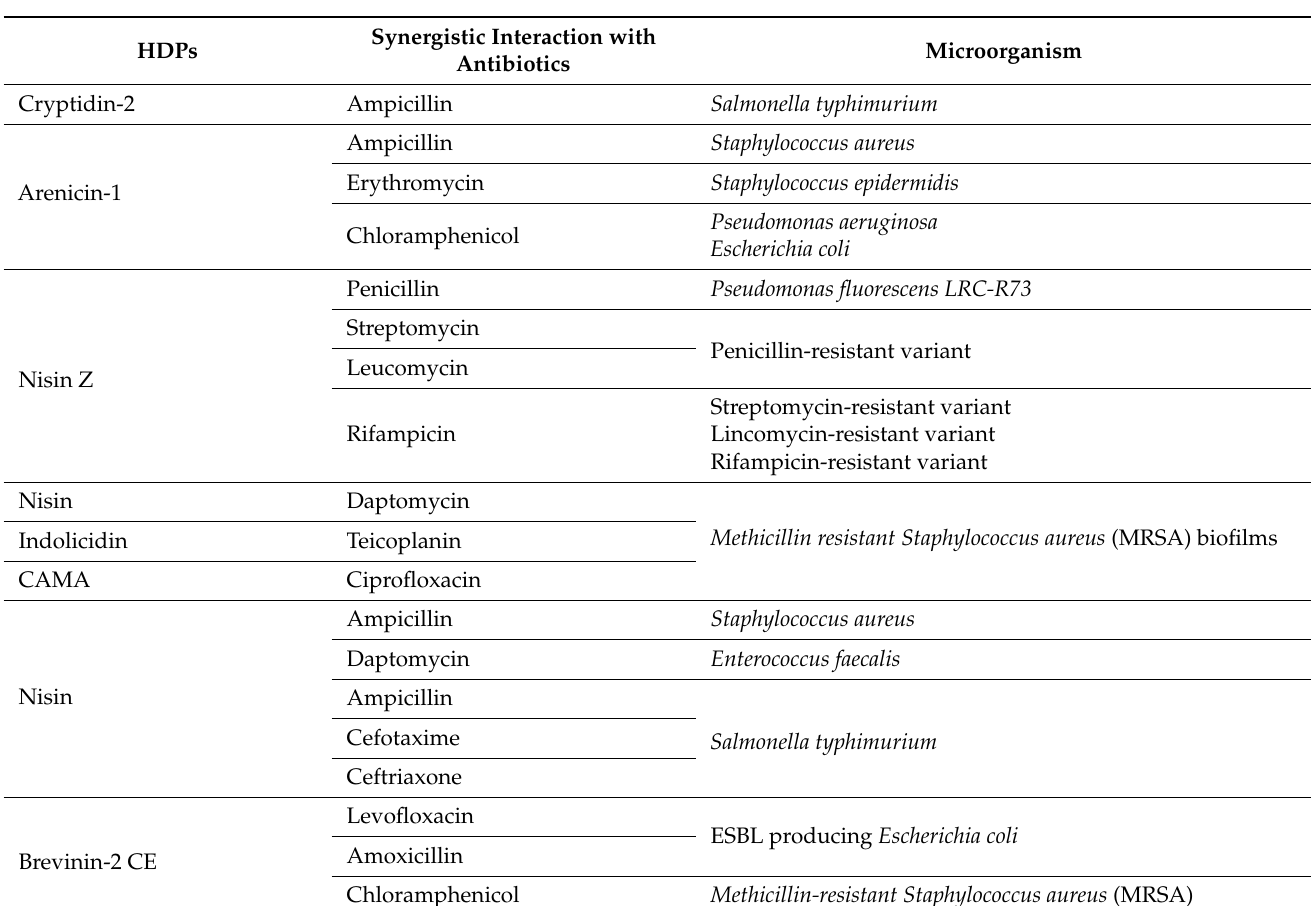
Table 6. Synergism between HDPs and antibiotics (adapted from ref.